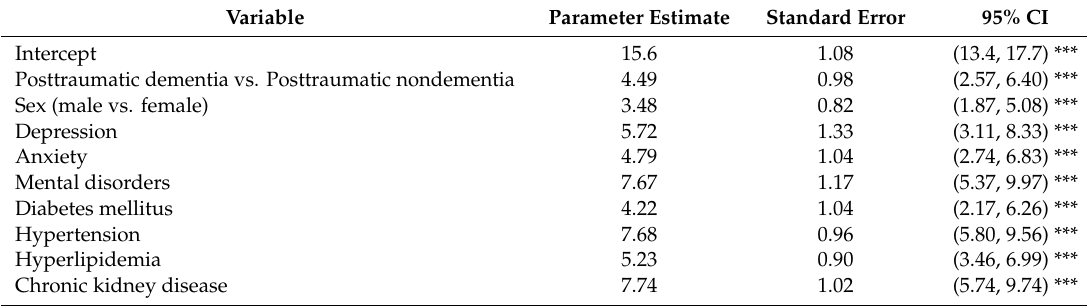
Table 3. Stepwise regression analysis for frequency of medical visits per year.